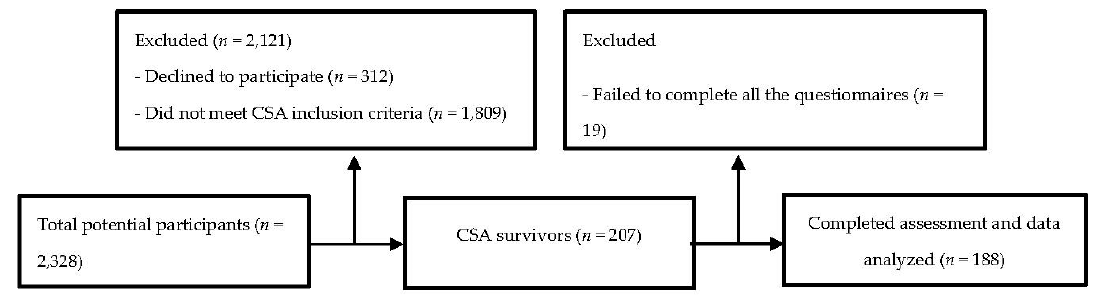
Figure 1. Flow chart for the recruitment of child sexual abuse (CSA) participants.